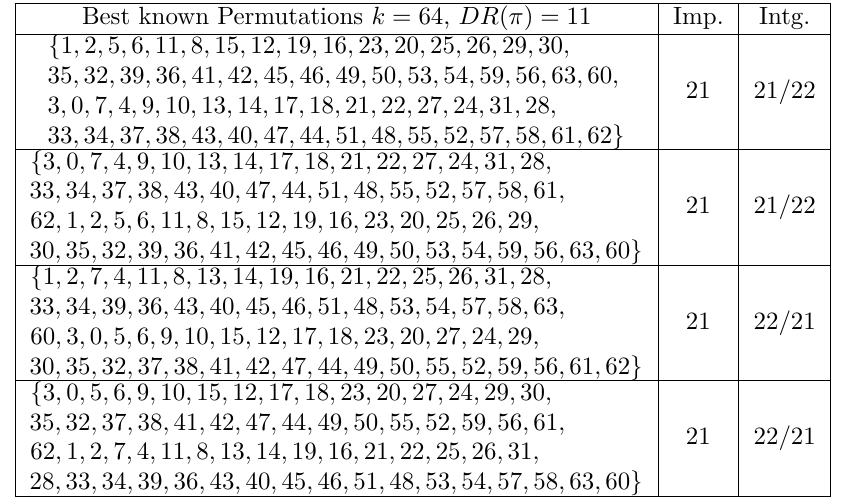
Table 23: Best known permutations k = 64 Best known Permutations k = 64, DR ( π ) = 11 Imp.